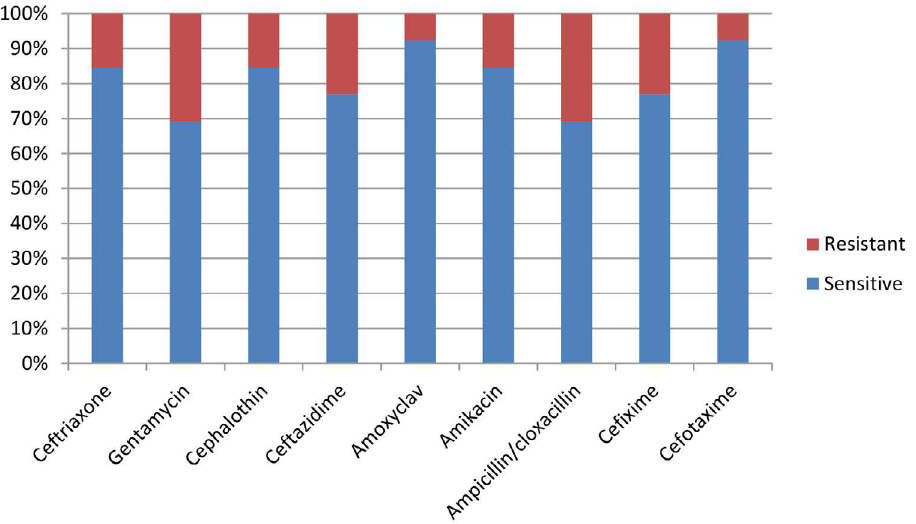
Fig. 3. Antibiotic sensitivity of isolates with less diversified plasmid DNA (13